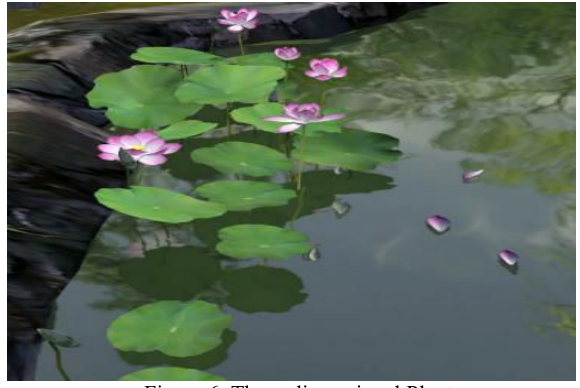
Figure 6. Three-dimensional Plant